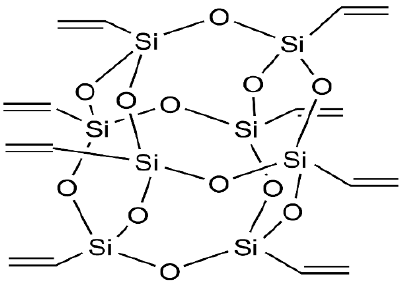
Figure 1. Structure of OV-POSS. Table 1. Information about materials used in this work .